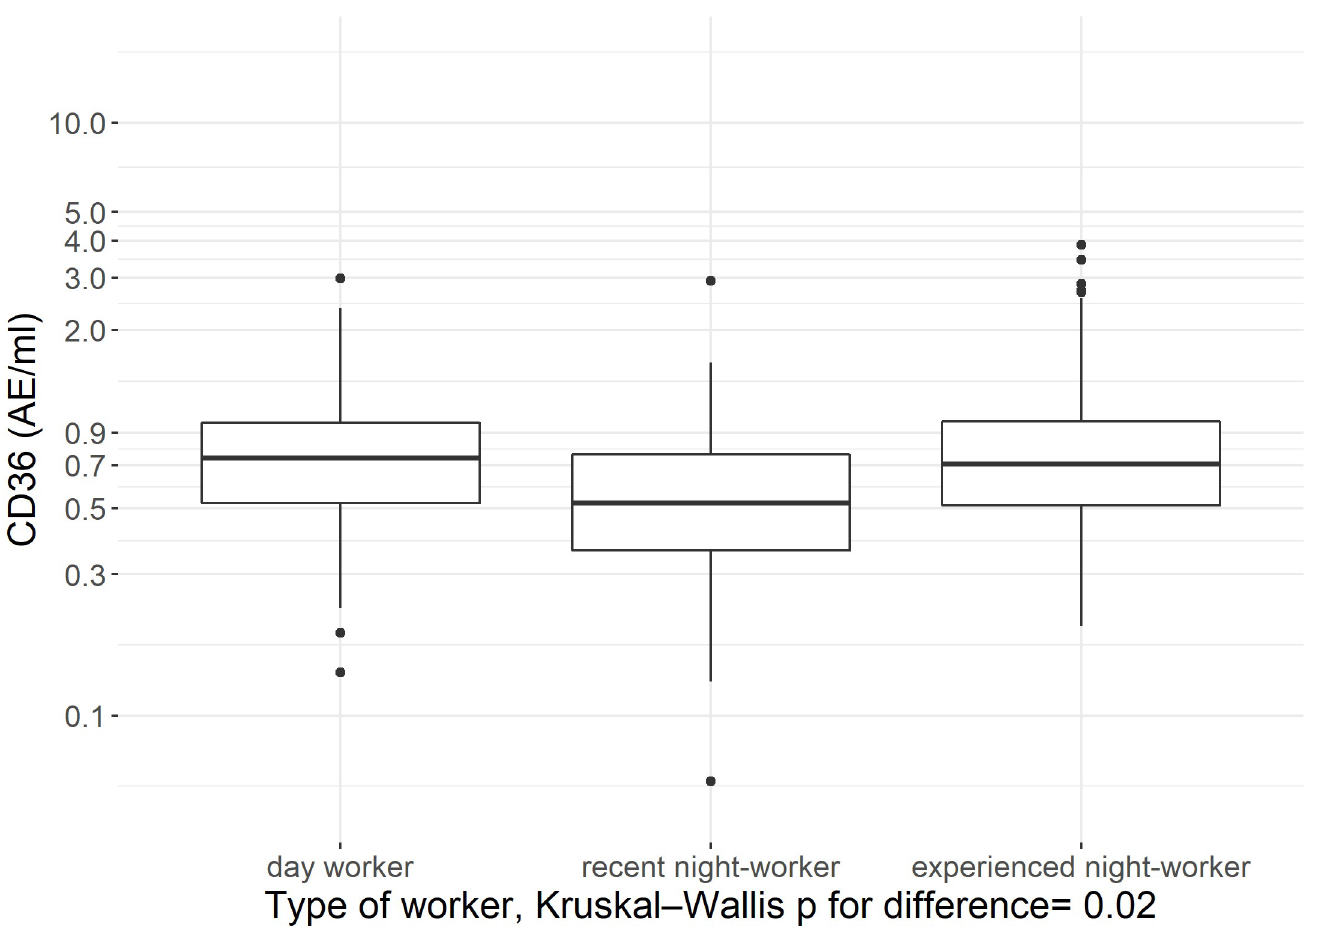
Fig 2. Log-transformed sCD36 levels in samples collected from day workers and night-shift workers during a day-shift session.